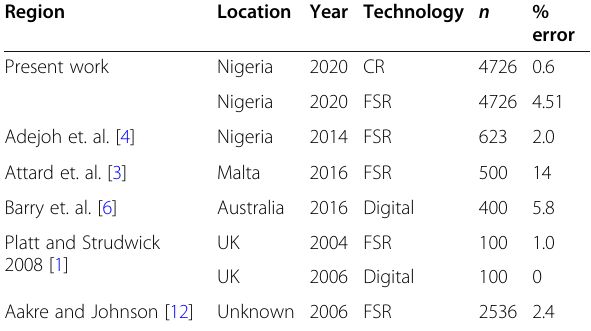
Table 4 Comparison of error rate with similar